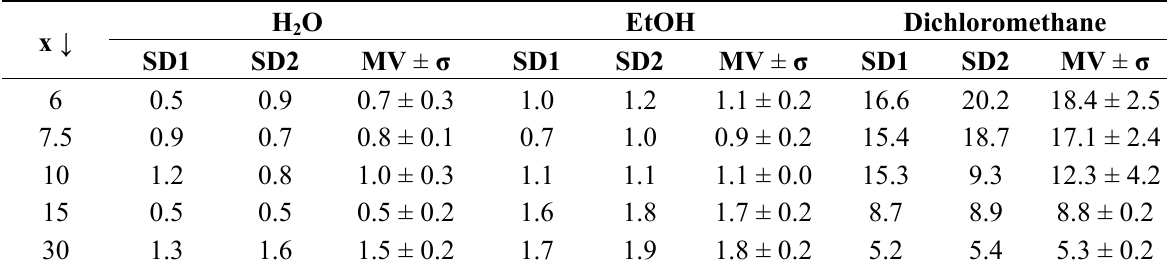
Table 4. The swelling degrees of p NonOx ethanol and dichloromethane. The swelling degrees according to ( m determined in duplicate [SD1 and SD2, respectively; the average is represented by the arithmetic mean value (MV) and the standard deviation, σ ].